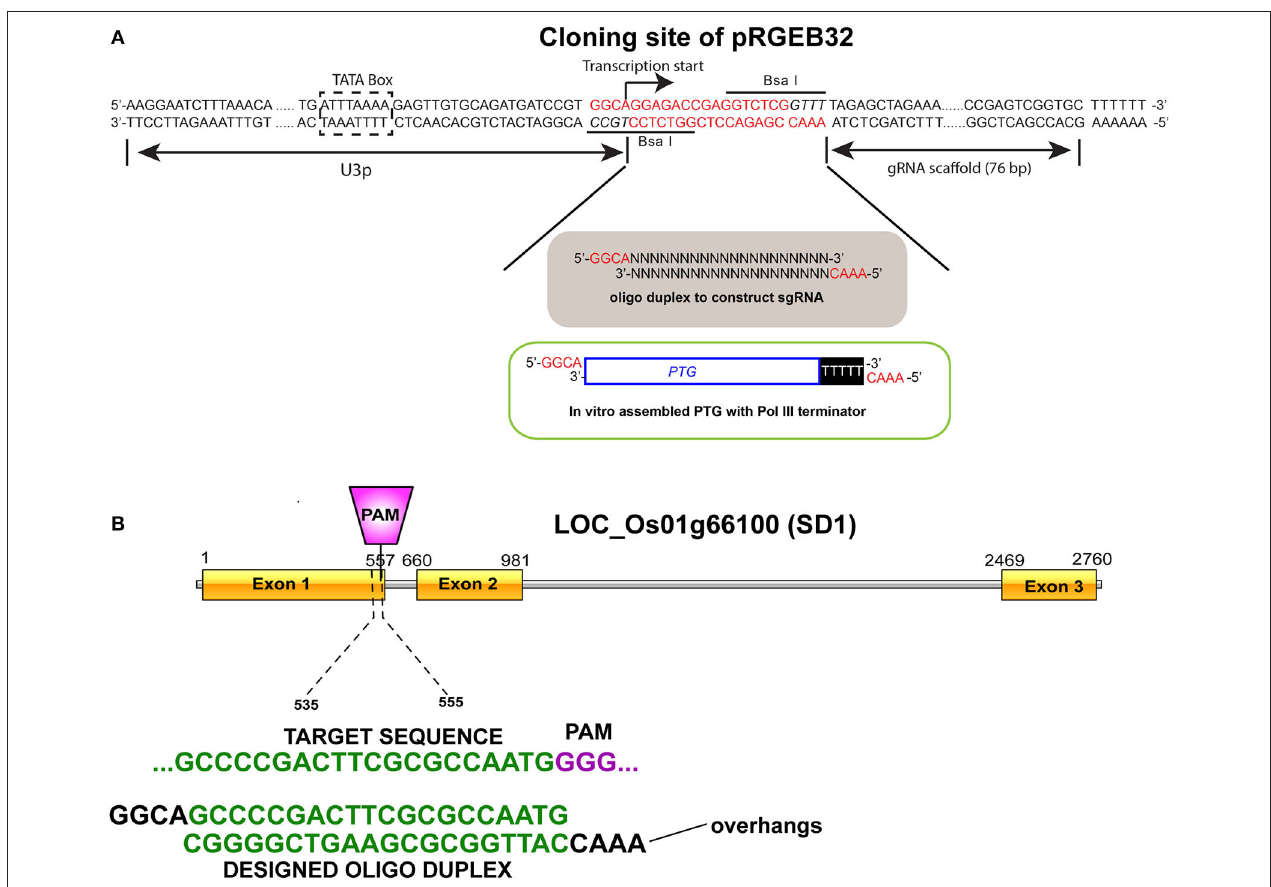
FIGURE 6 | Single guard ribonucleic acid (sgRNA) for targeted genome engineering. (A) Cloning site of pRGEB32 plasmid when digested with BsaI restriction enzyme leaves a four-base overhang on either side. (B) Target site for sgRNA binding at the exon 1 of the OsGA20ox2 gene (LOC_Os01g66100). A 20-nt oligonucleotide complex was designed and ligated with the pRGEB32